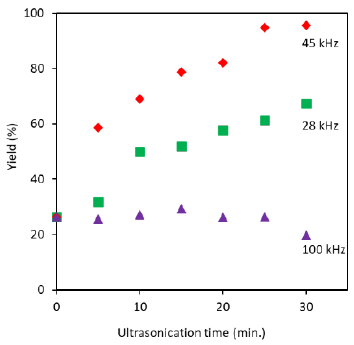
Figure 1. Dependence of yields on the ultrasonication frequency at 28, 45, and 100 kHz and ultrasonication time.